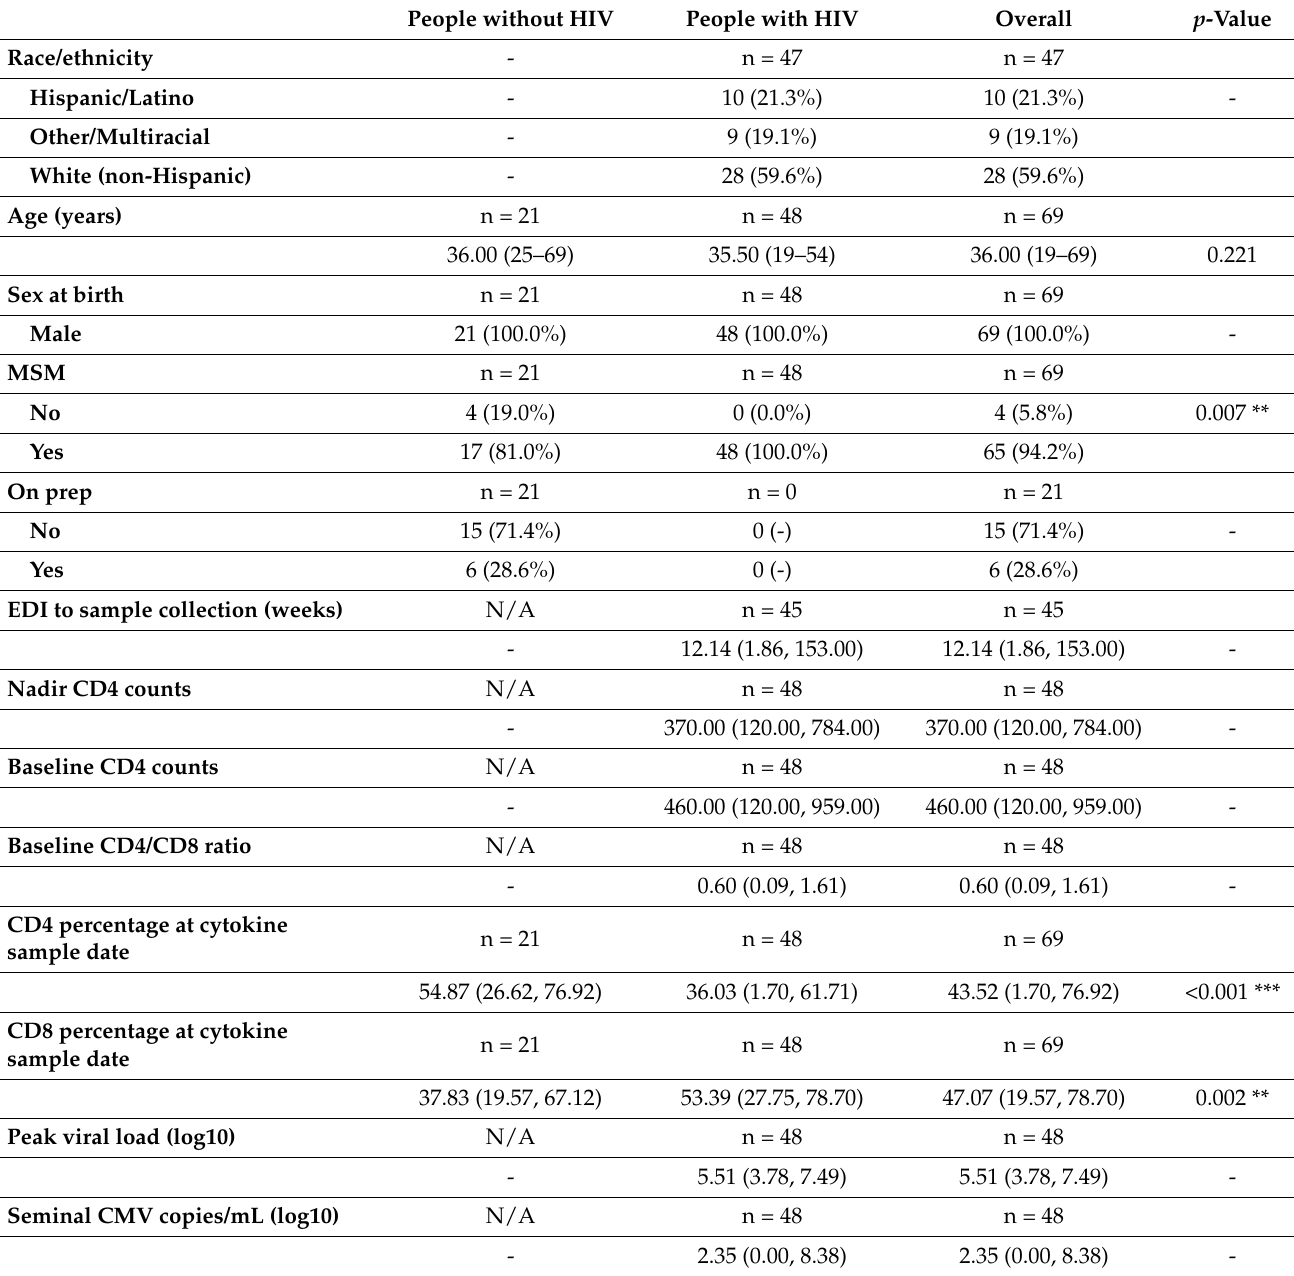
Table 1. Demographic and clinical information: people with and without HIV. People without HIV People with HIV Overall p -Value